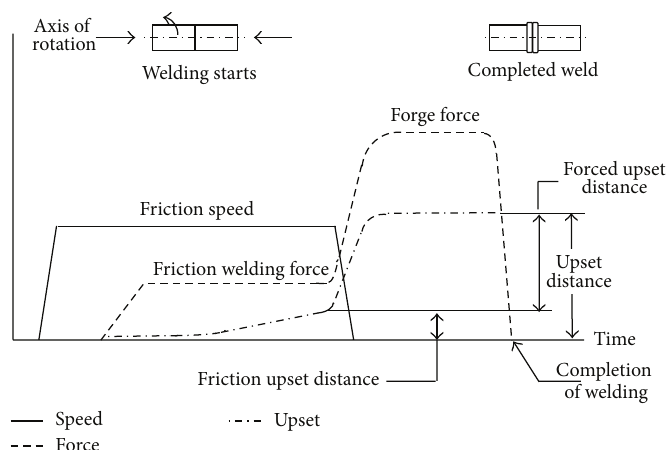
Figure 3: Process parameters in direct drive friction welding technique [22].